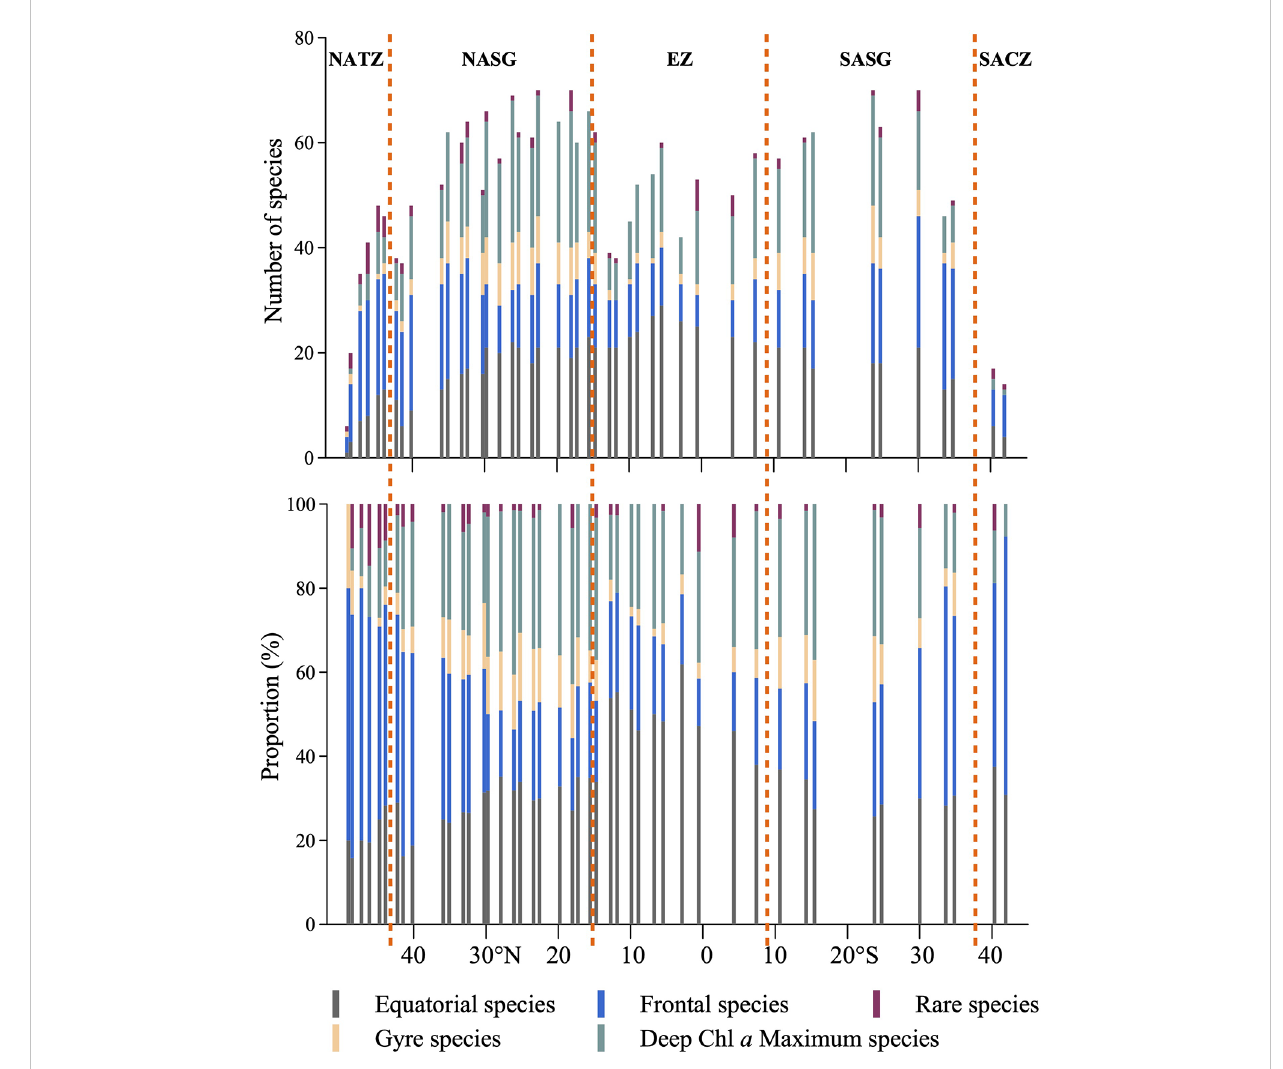
FIGURE 10 Latitudinal variation of Tintinnina species-number in each biogeographic pattern along the AMT transect. NATZ, North Atlantic Transition Zone; NASG, Northern Atlantic Subtropical Gyre; EZ, Equatorial Zone; SASG, Southern Atlantic Subtropical Gyre; SACZ, South Atlantic Convergence